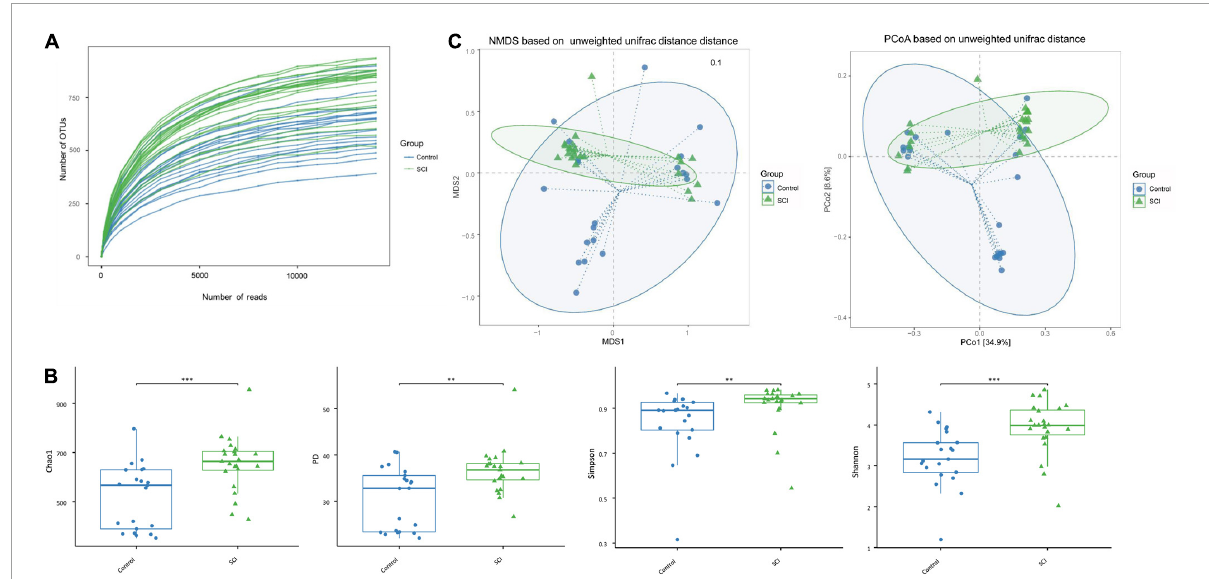
FIGURE2 The a-diversity and b-diversity indexes of the gut microbiota in fecal samples of SCI patients and healthy controls. (A) Dilution curve of the samples. (B) The α -diversity was evaluated by species richness index (PD and Chao1) and species diversity index (Shannon and Simpson). Based on unweighted UniFrac algorithm. Each box represents the median, interquartile range, minimum and maximum values. (C) The β diversity was analyzed with NMDS and PCoA. ** p < 0.005, *** p <